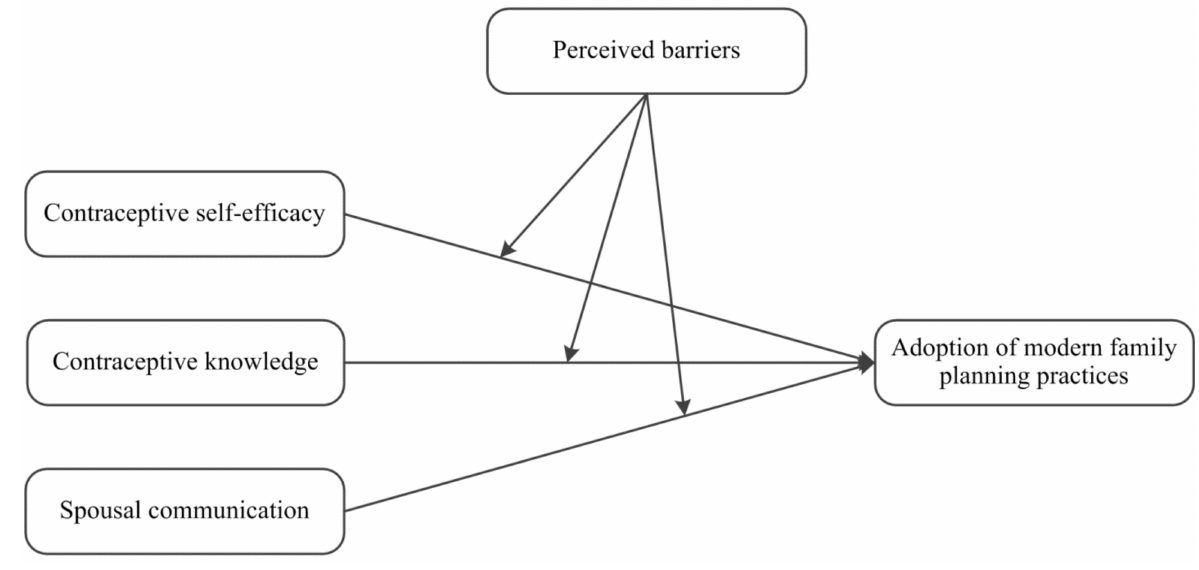
Figure 1. Research